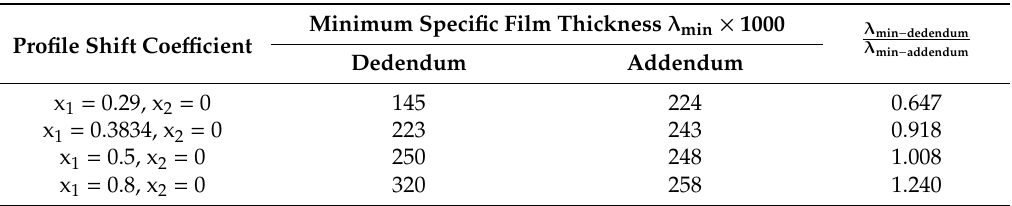
Table 6. Minimum specific film thickness for di ff erent profile shift coe ffi